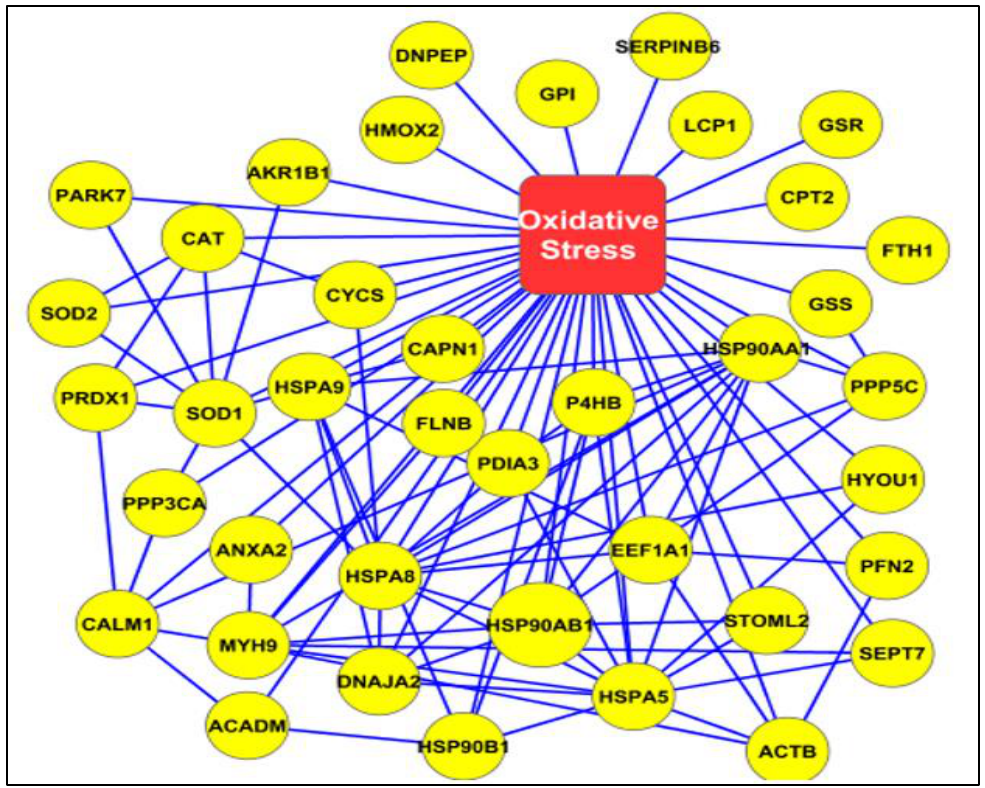
Figure 4. Interaction network of acetylated proteins associated with oxidative stress.